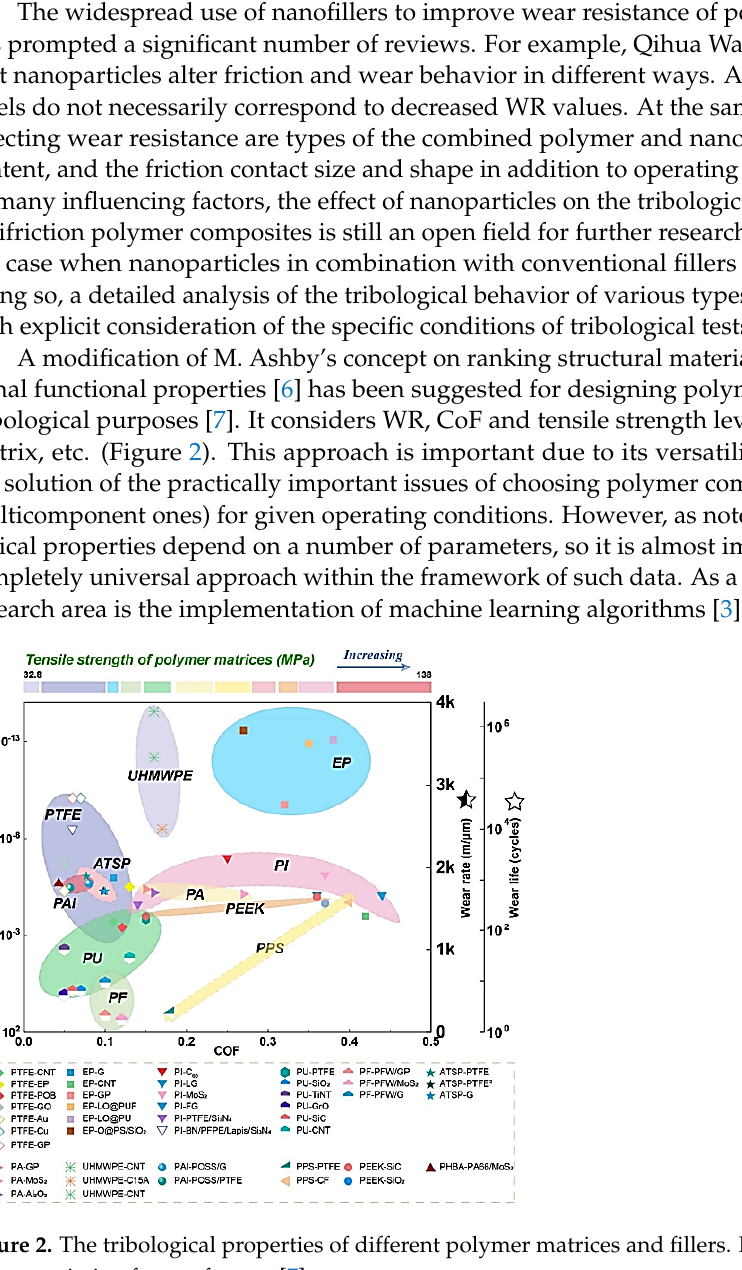
Figure 1. A summary of the structural components of the wear resistant polymer composites. Figure is reproduced with permission from reference [3].